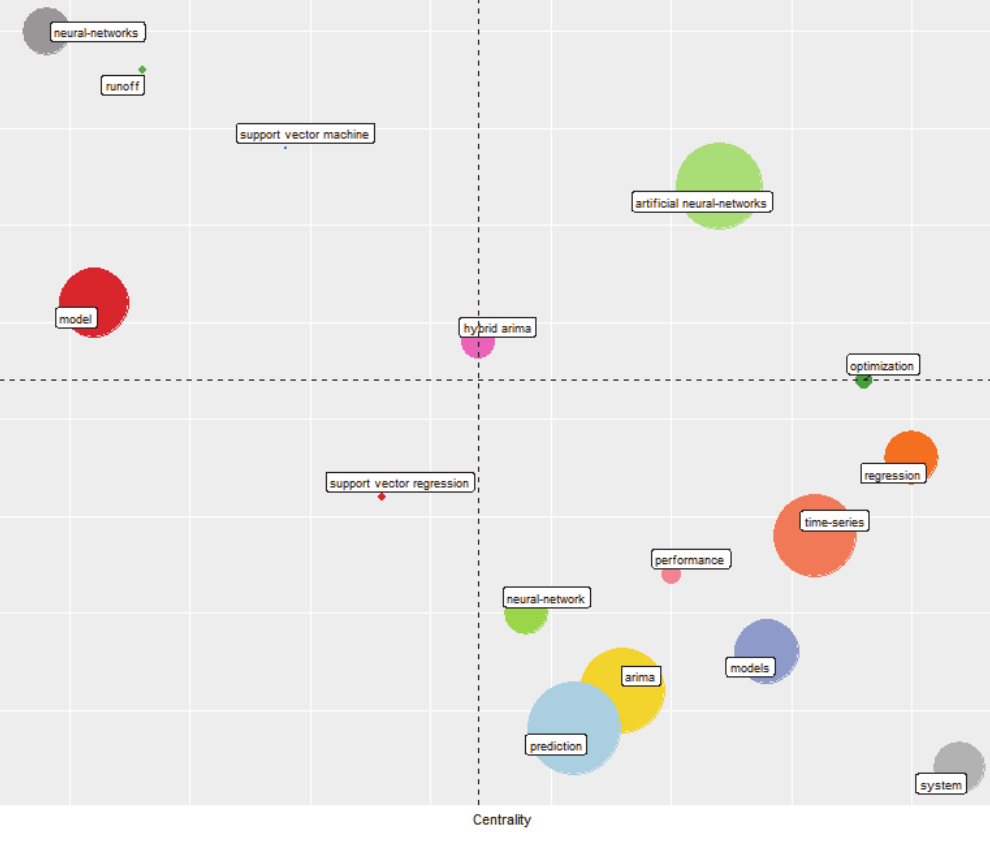
Fig. 3. Thematic Map